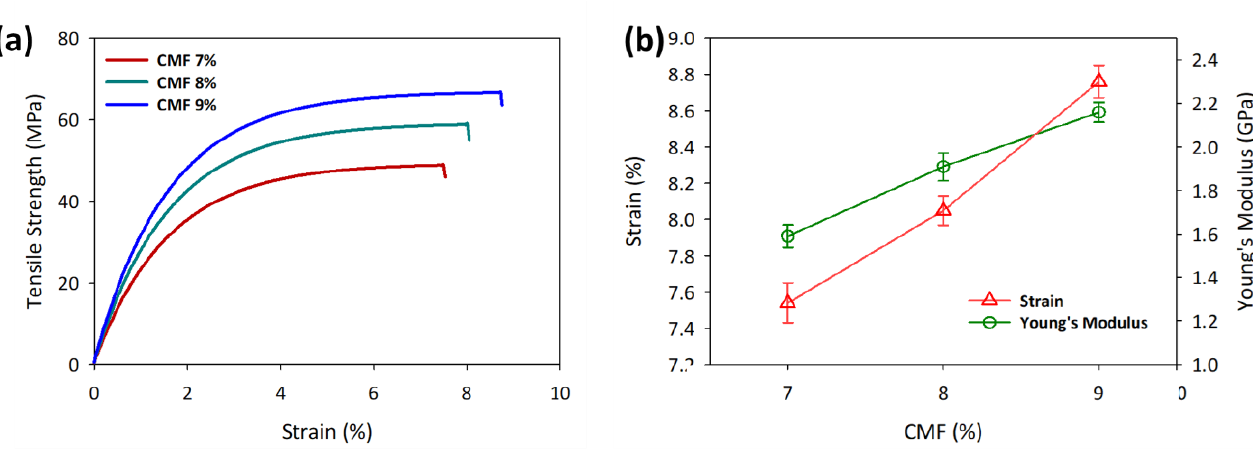
Figure 4. Mechanical properties of printed samples of CMFs at different concentrations in ( a ) stress–strain curve and ( b ) Young’s modulus. The data are presented as mean ± standard deviation (n = 3).